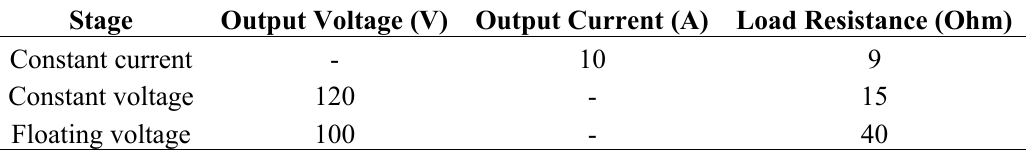
Table 5. Three-stage charging process parameter